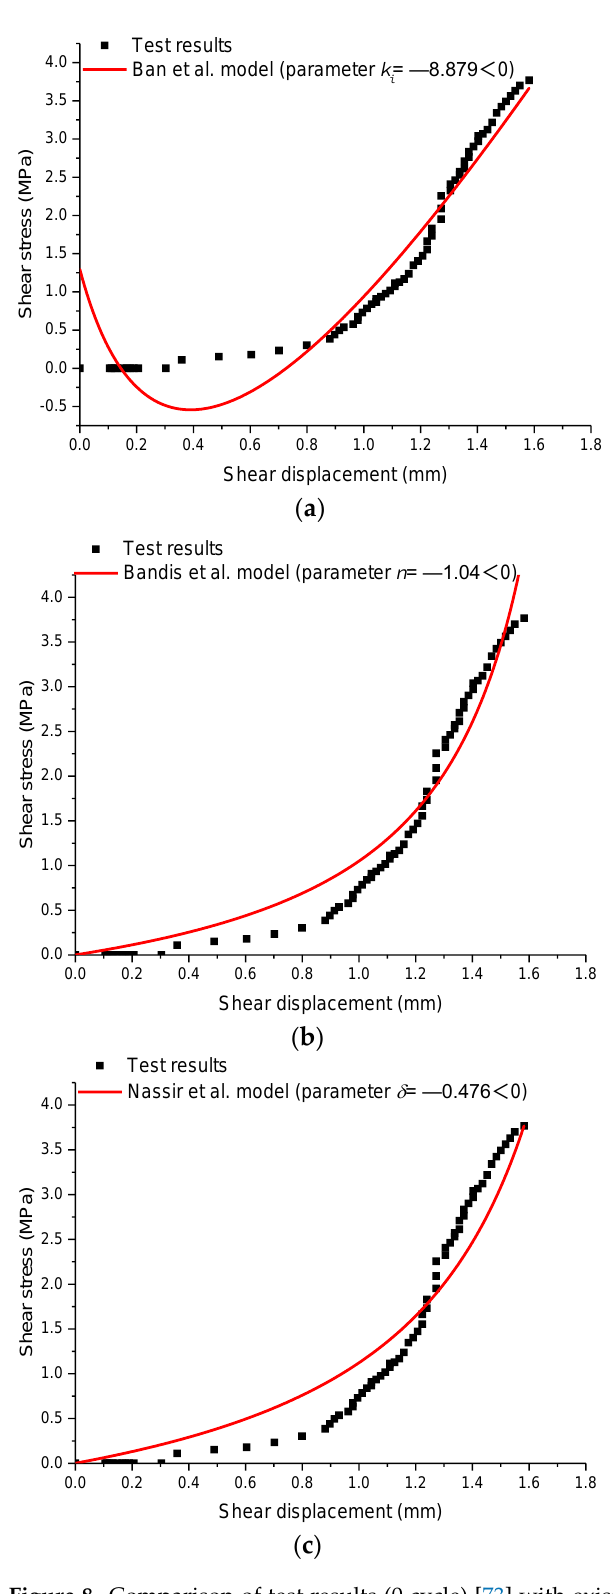
Figure 7. Comparison of test results [73,74] with model curves.